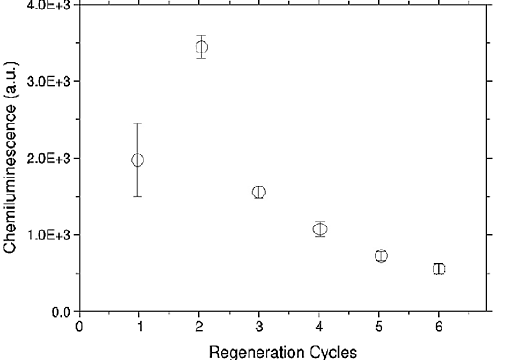
Figure 6. Chemiluminescence detection of AFM1 on Si 3 N 4 substrates after regeneration cycles with 100 mM glycine-methanol solution. The data are reported as a mean value of three samples and the error bars are reported as standard deviations.